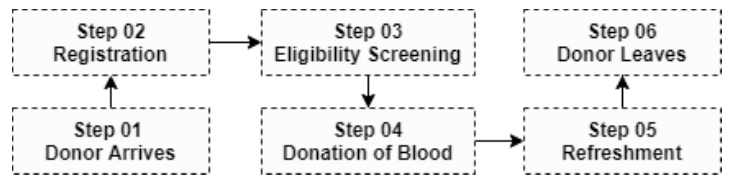
Figure 1. Typical path of a donor at a donation